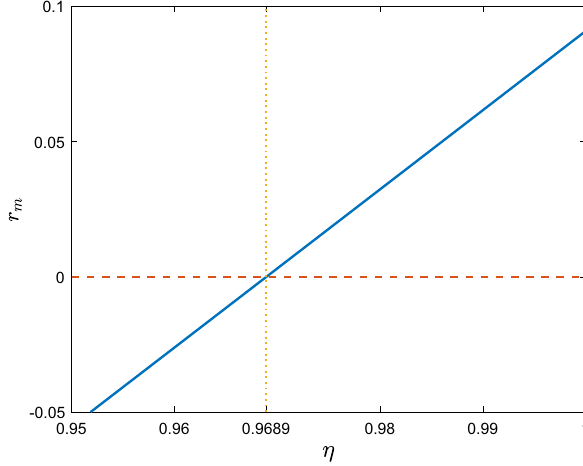
Fig. 2 The violation ratio r for the first (second) inequality, as a func- ) tion of ϕ (2 ξ ) for η c ( χ c 0